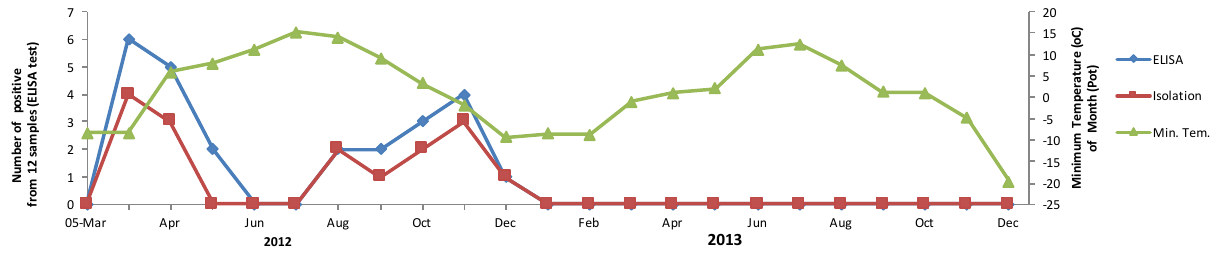
Figure 4. Detection of Xylella fastidiosa in roots of almond trees in outdoor pots during 2012-13.